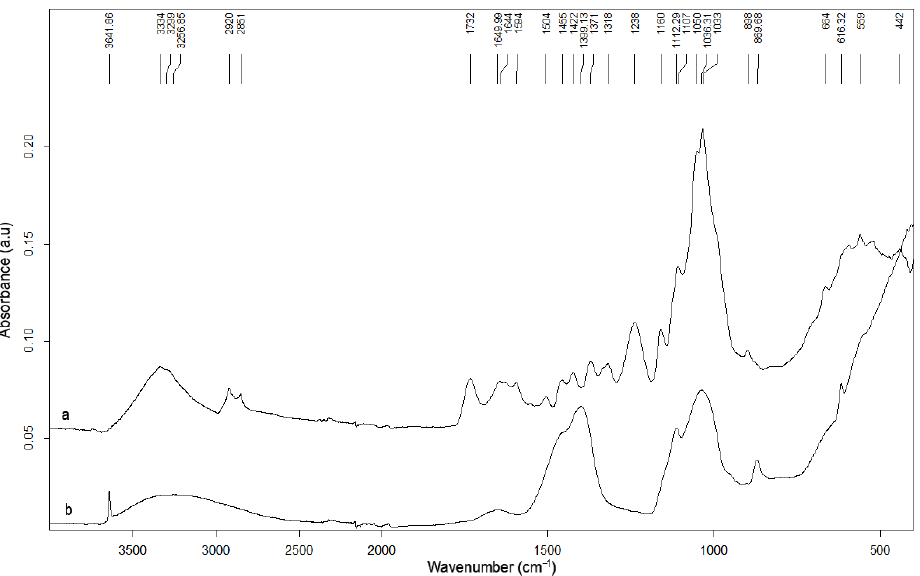
Figure 1. Infrared spectra of the yerba mate (YM) ( a ) and calcinated yerba mate (CYM) ( b ) samples.